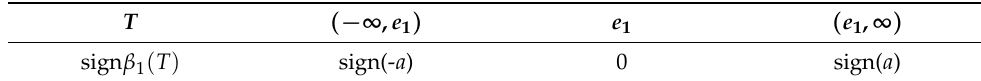
Table 2. The sign of β 1 ( T ) when there is one root e 1 .